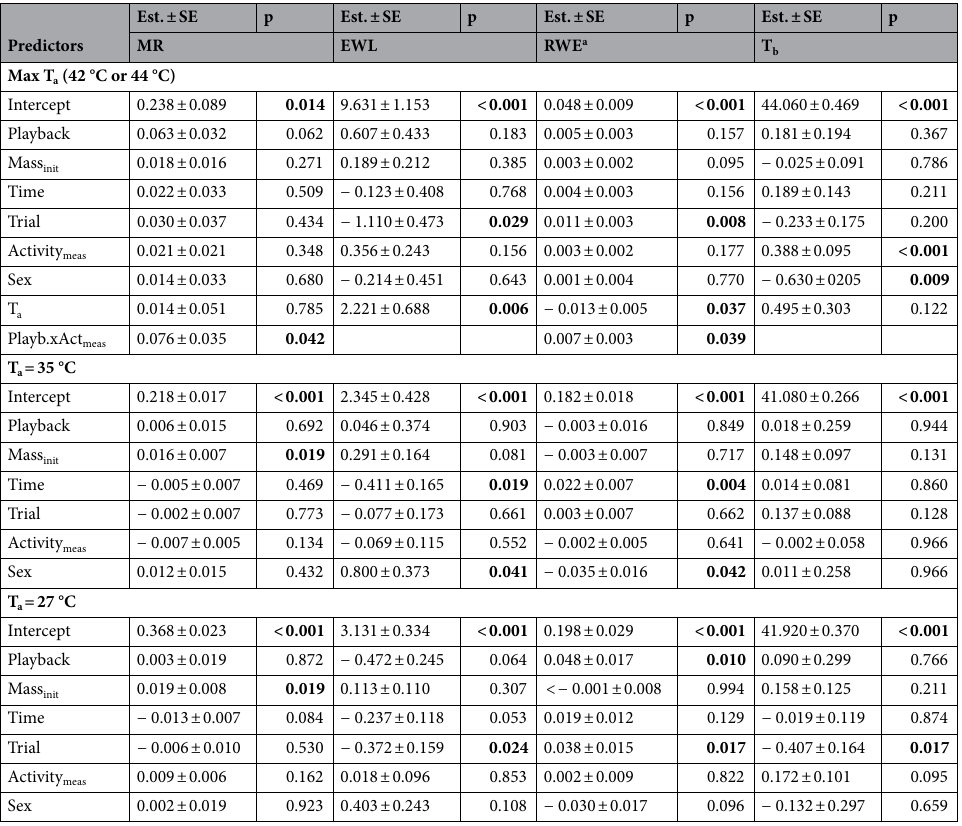
Table 1. Outputs of reduced linear mixed-effects models of metabolic rate (MR), evaporative water loss (EWL), relative water economy (RWE) and T b of calm individuals at the maximal T a reached (i.e. T a = 42 °C or 44 °C, n = 32 observations for 19 birds), within the thermoneutral zone (T a = 35 °C, n = 67 for 34 birds) and at mild temperature (T a = 27 °C, n = 67 for 34 birds). The reference is the control group for playback, morning for time-of-day (here “Time”), trial 1 for trial, and female for sex. Mass init corresponds to the mass measured before starting the trial. Est. ± SE corresponds to estimate ± standard error. Bold font shows significant effect (p < 0.05). a Patterns for evaporative cooling efficiency (EHL/MHP) were always consistent with those on RWE, with the same predictors having significant effects in the opposite direction (see Supplementary Table